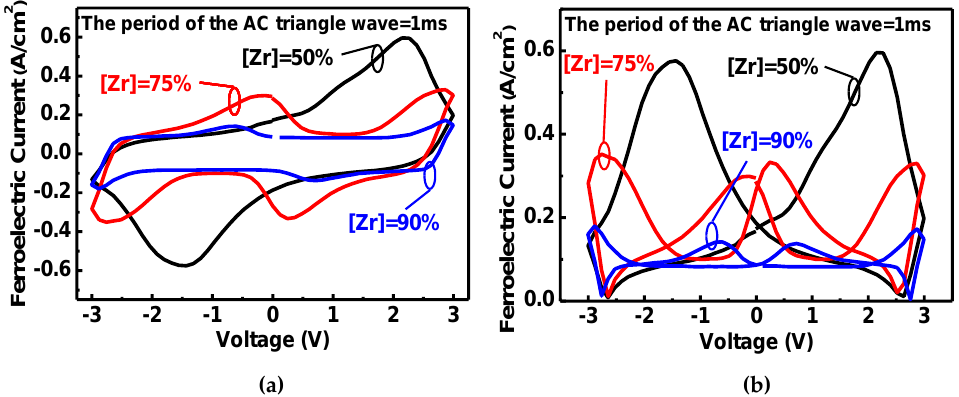
Figure 6. The AC-based ferroelectric polarization current of (A)FeCAPs for ( a) raw data, and ( b ) the absolute value (amplitude only). The orthorhombic phase and the switchable dipoles of (A)FeCAPs are decreased with Zr composition enhancement that causes the I FE to be decreased under bipolar operation.